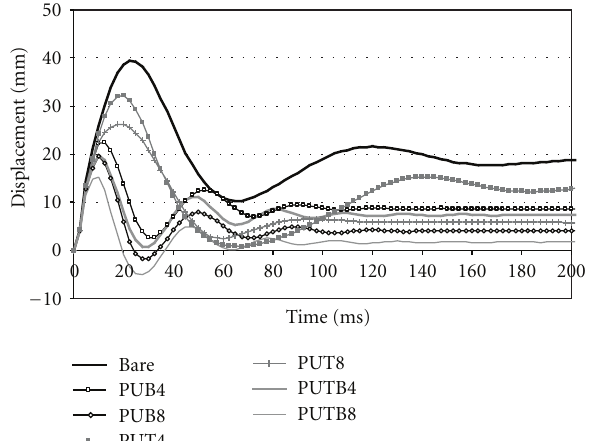
Figure 6: Peak kinetic energy in concrete and reinforcements of selected